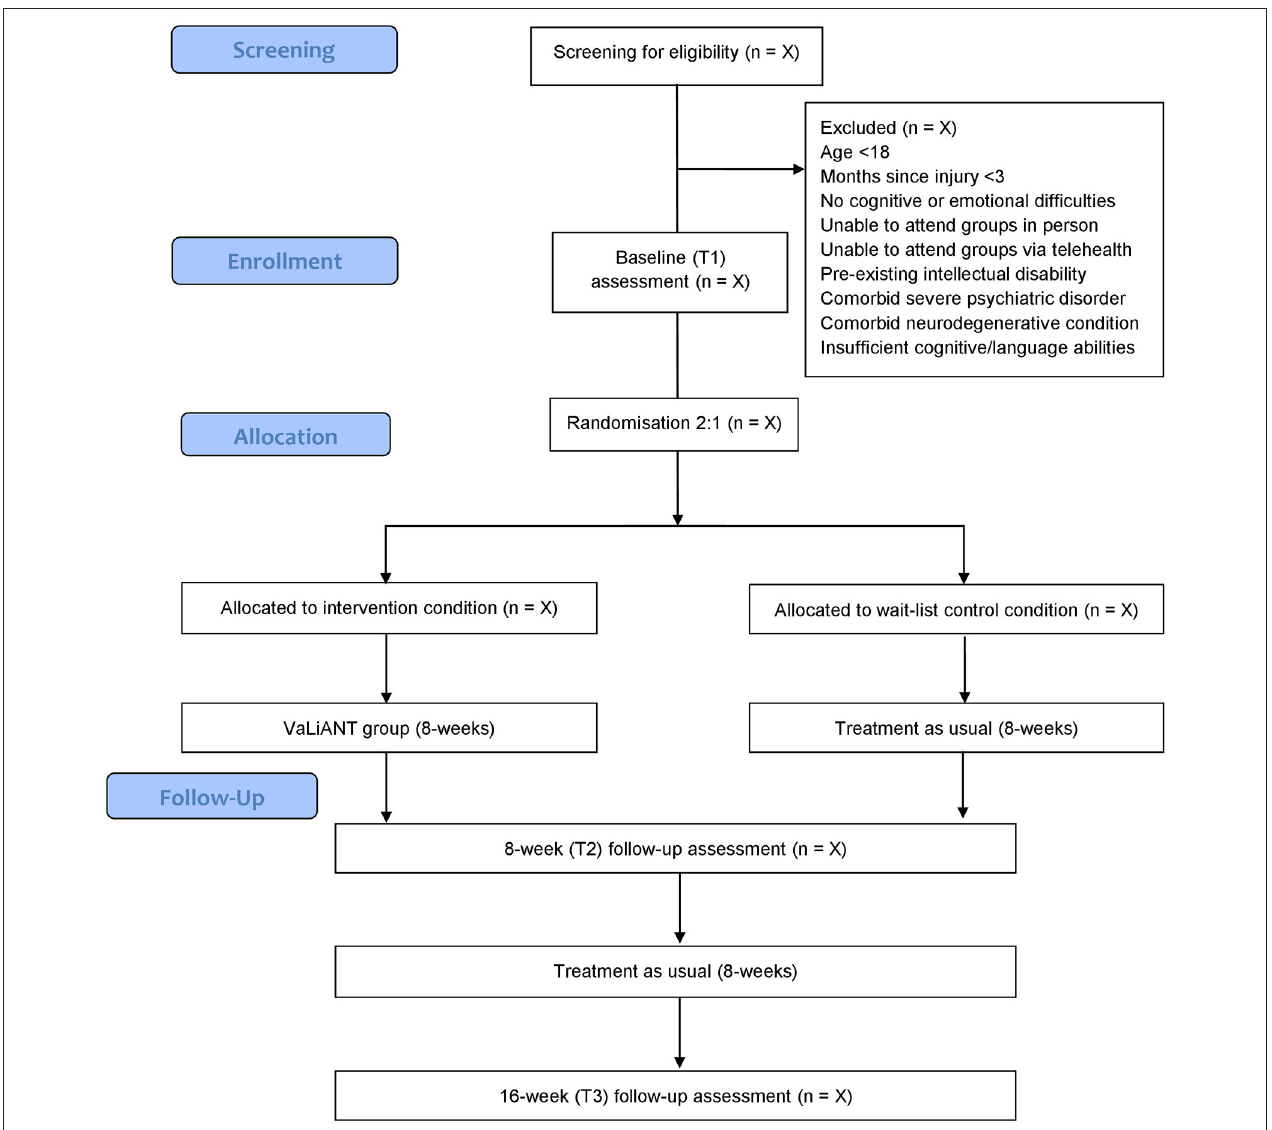
FIGURE 1 | Study flow diagram. VaLiANT, Valued Living After Neurological